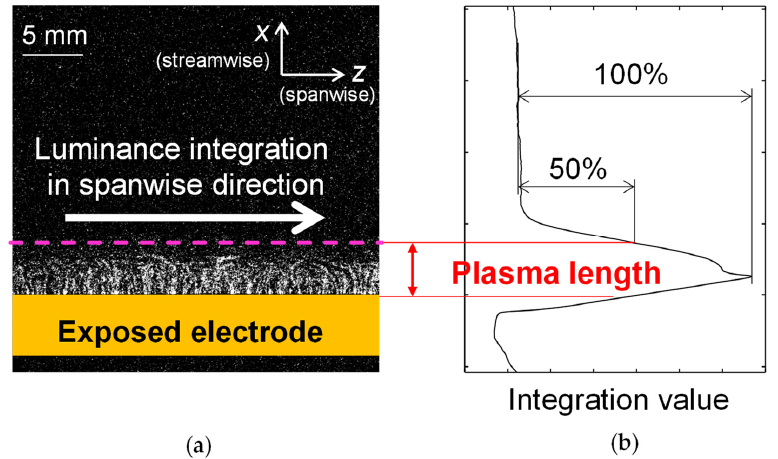
Figure 9. Analysis of plasma extension length, ( a ) discharge image acquired using ICCD camera; ( b ) definition of plasma length.